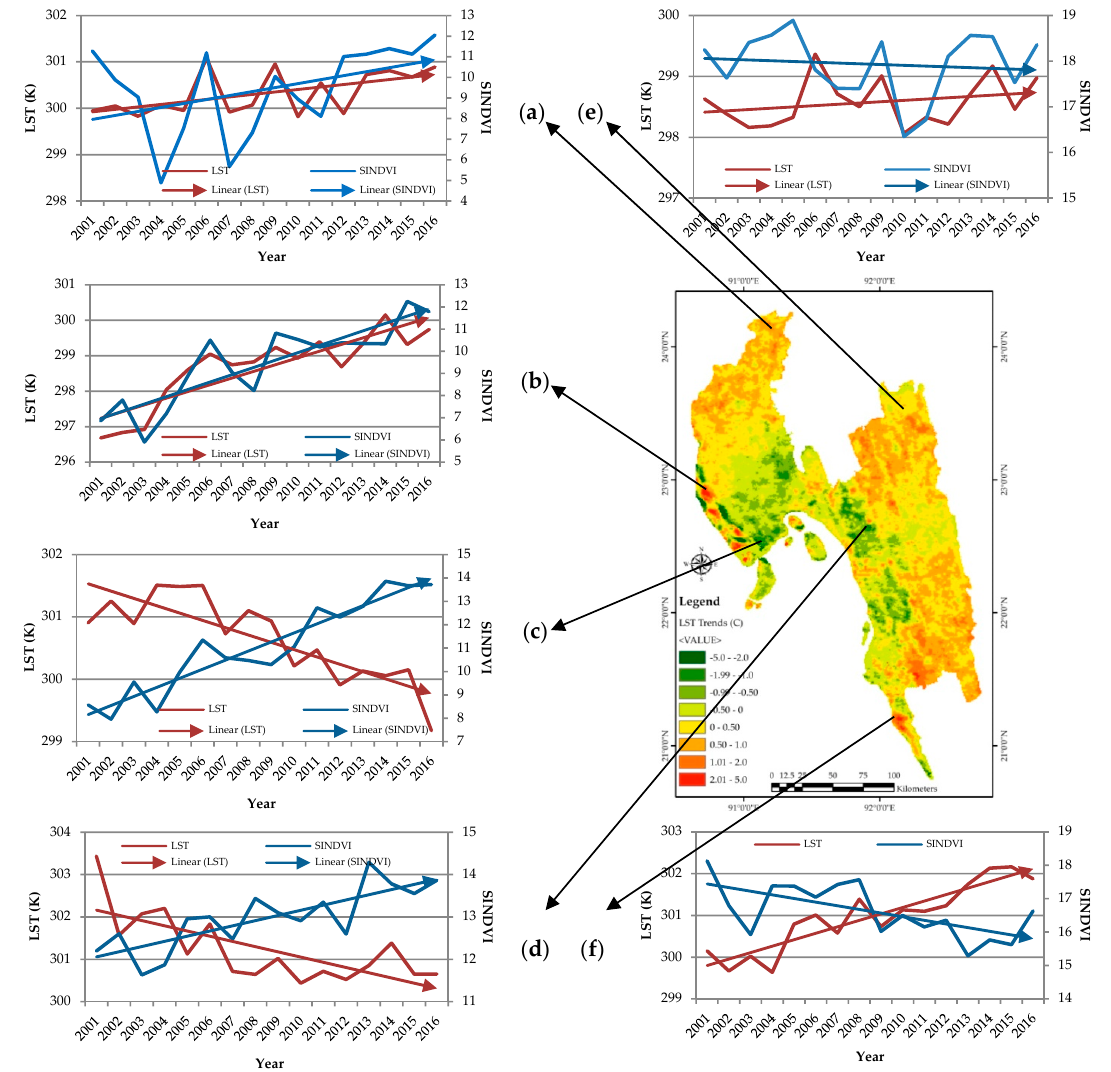
Figure 8. The interannual average LST and SINDVI of the extremely impacted grid cells area (0.008833 × 0.008833) for six different regions of the study area. The map in the main panel inserted represents the range of LST from 2001 to 2016.